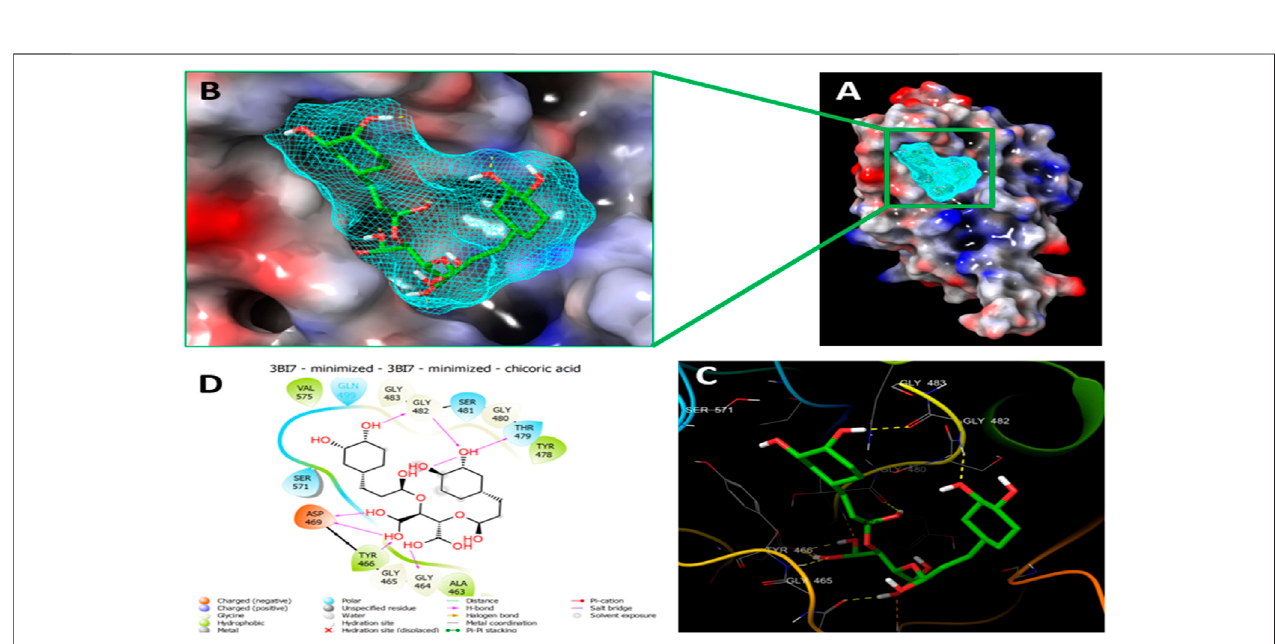
FIGURE3| MolecularDockingofnytose withUHRF1. (A) Molecular surfacedisplay withanelectrostatic potential colorschemeforUHRF1- Nystose complexand theclose-upviewpresented. (B) PutativebindingmodeofNystoseinthebindingsiteofUHRF1(PDB:3BI7). (C) Nystosewasdisplayedasgreenball-and-sticks.Andthe amino acid residues of the binding site are represented as grey sticks, and H-bonds are expressed in yellow dotted lines. (D) 2D depiction of the lig-and-protein interactions.